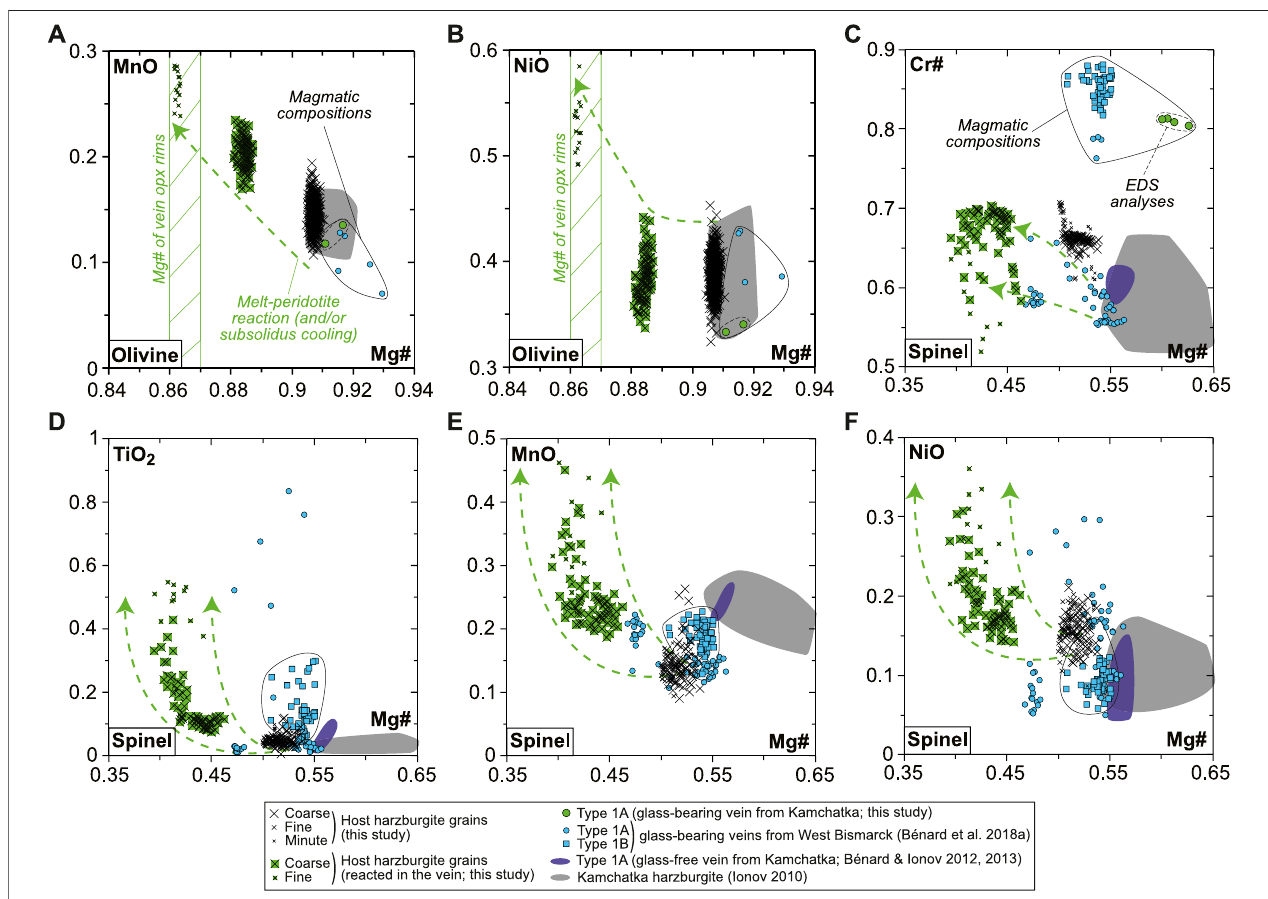
FIGURE 2 | Olivine and spinel major element compositions (in wt% for oxides) for the new Kamchatka sample in this study. (A,B) Olivine compositions and (C – F) spinel compositions. Also shown are data for glass-free Type 1A veins from Kamchatka (dark-blue fi elds and symbols; Bénard and Ionov, 2012, 2013), glass-bearing Type1A(dots)and Type1B(squares) veins fromWestBismarck(blue fi eldsand symbols; Bénard et al.,2018a),and Kamchatkaspinelharzburgite residues(gray fi elds; Ionov, 2010).